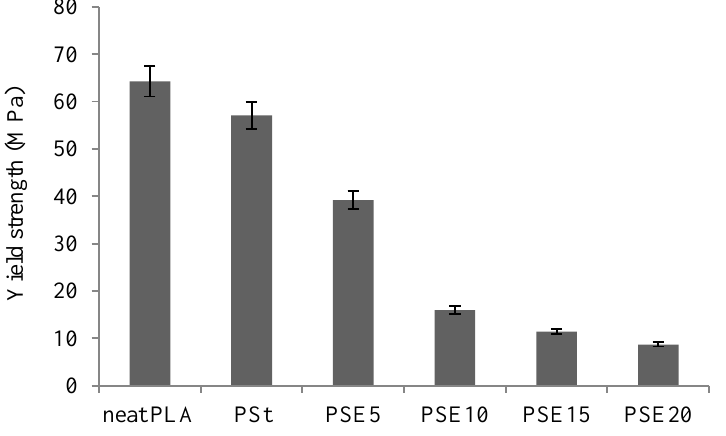
Figure 4. Yield strength of neat PLA, PSt, and PSE blends.